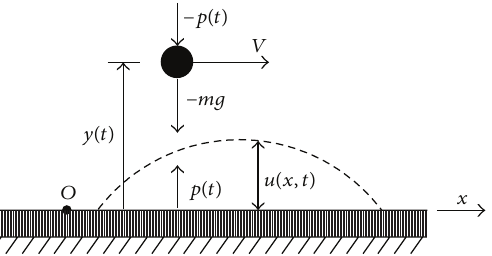
Figure 2: The interaction between the mass and the